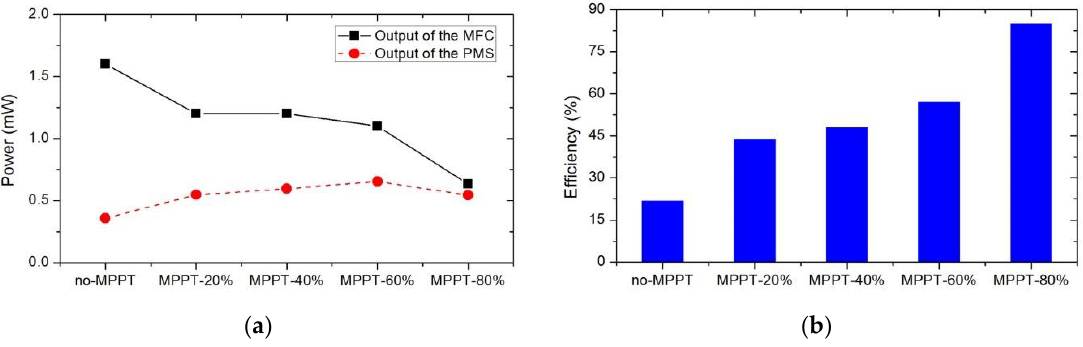
Figure 10. ( a ) Average input power from the MFC and output power of the PMS as functions of MTTP voltage ratio: ( b ) Efficiencies of the PMS in different MTTP voltage-ratio configurations.